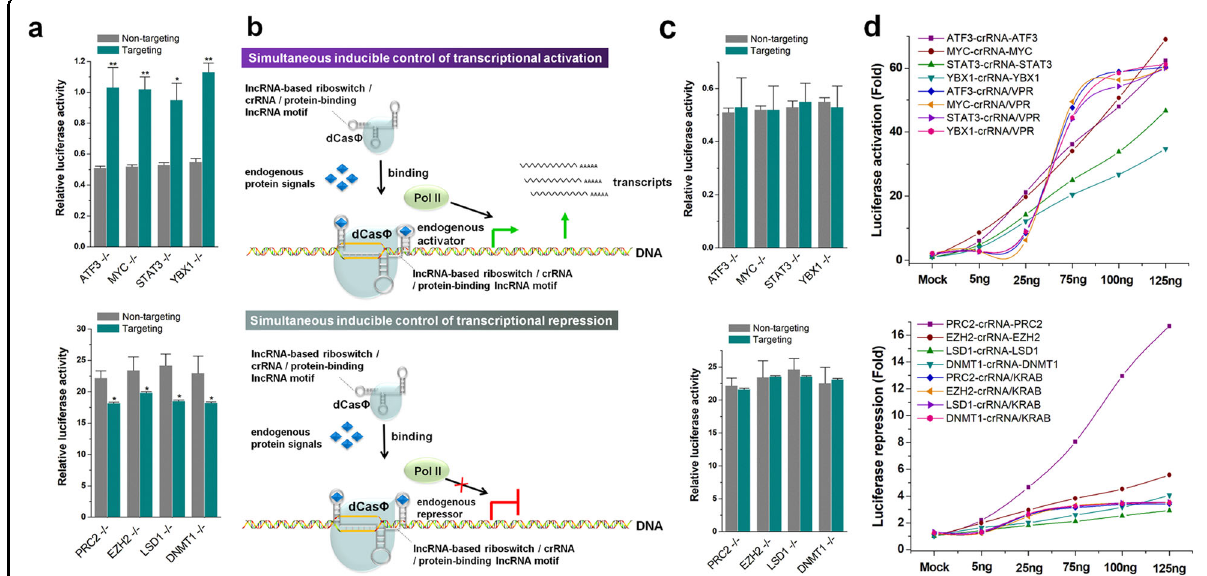
Fig. 4 Dynamic and sensitive responses to endogenous protein signals. a The inducible dCas Φ -VPR and dCas Φ -KRAB systems showing basic transcriptional regulatory activity on Rluc. b Schematic diagram of the simultaneous inducible control of transcriptional activation. c The simultaneous inducible CRISPR transcriptional systems did not show any leakage. d The simultaneous inducible CRISPR systems showed a broader signal response range than the previous systems. The data were normalized to those of the non-targeting crRNA group and displayed as average percentages (%). Relative luciferase activities were determined as the ratios of Rluc to Fluc values. Error bars represent the SD from fi ve independent experiments. * P < 0.05; ** P < 0.01, relative to the control, two-tailed t